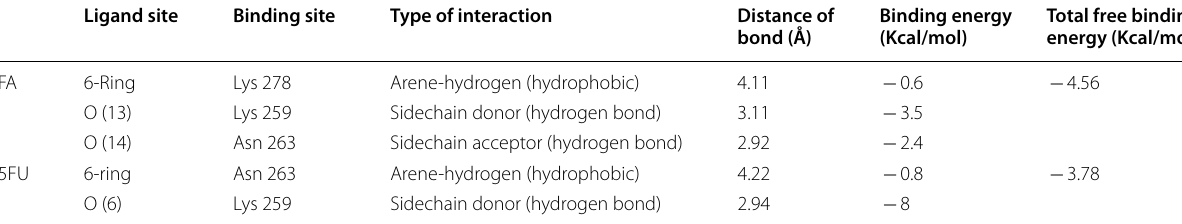
Asn asparagine, O oxygen, N nitrogen, Lys lysine